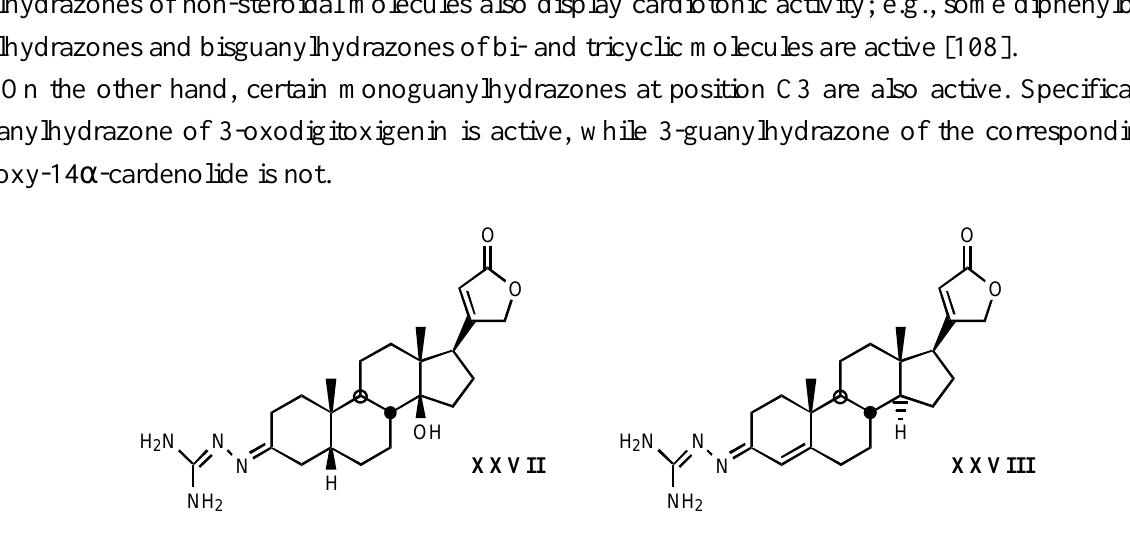
Figure 25. Structure of 3-guanylhydrazones of 3-oxodigitoxigenin ( XXVI ) and 14-deoxy-14 a - digitoxigenin ( XXVII